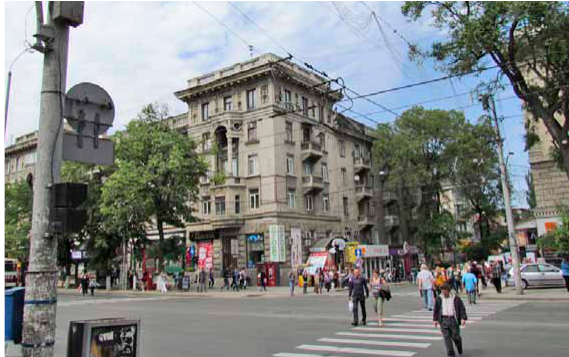
fig. 10. former lenin Prospect in Chisinau, Moldova. r. Če- paitienė photo